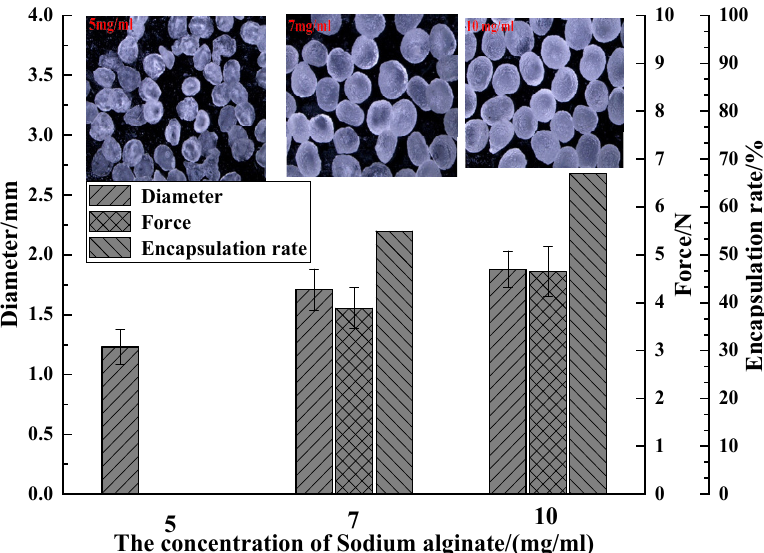
Figure 6. Comparison of capsule diameter distribution, strength and encapsulation rate as related to the concentration of sodium alginate solution.